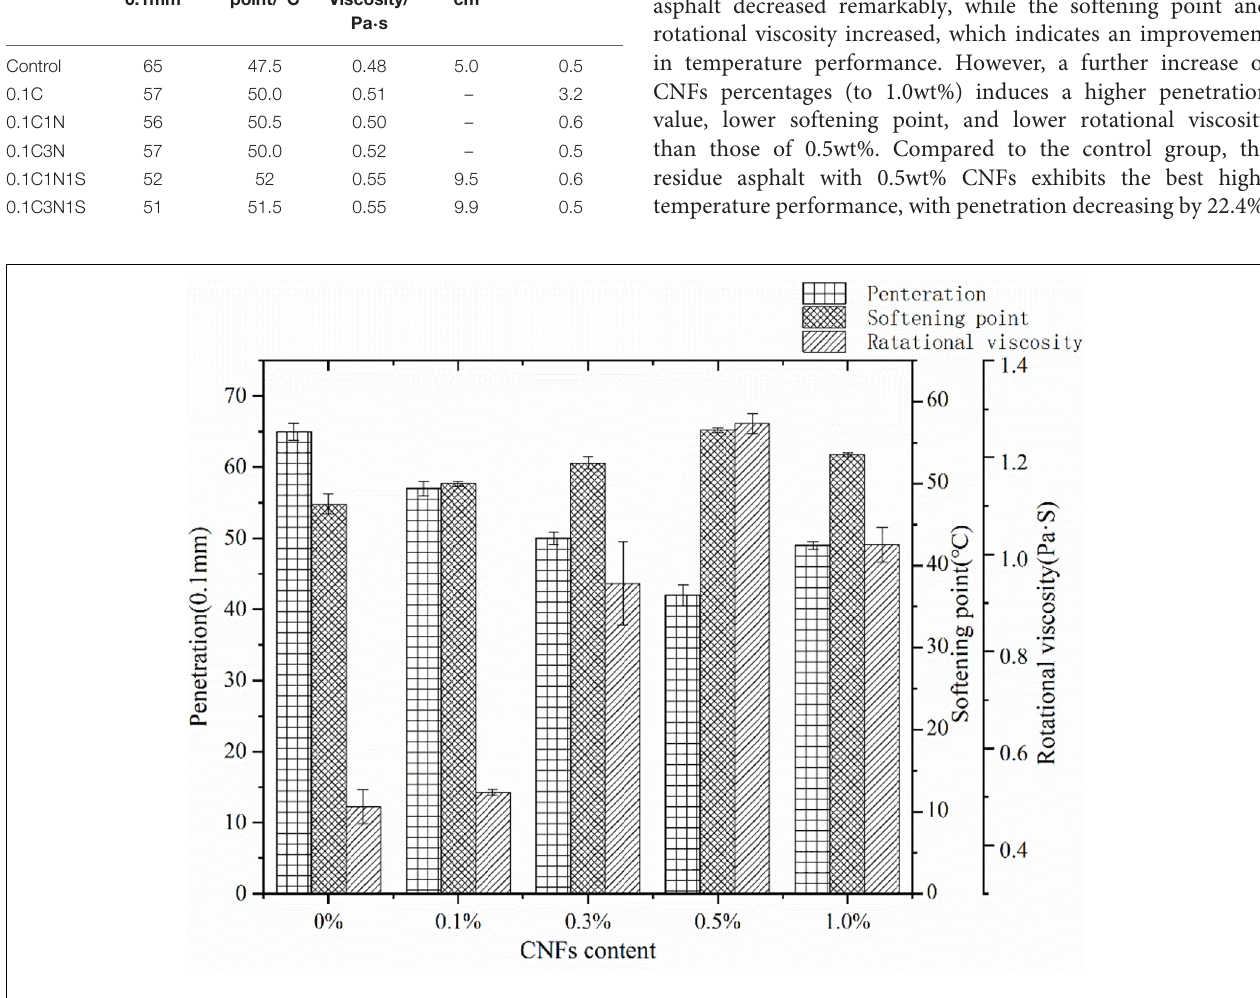
FIGURE 6 | Penetration, softening point and rotational viscosity with various CNFs